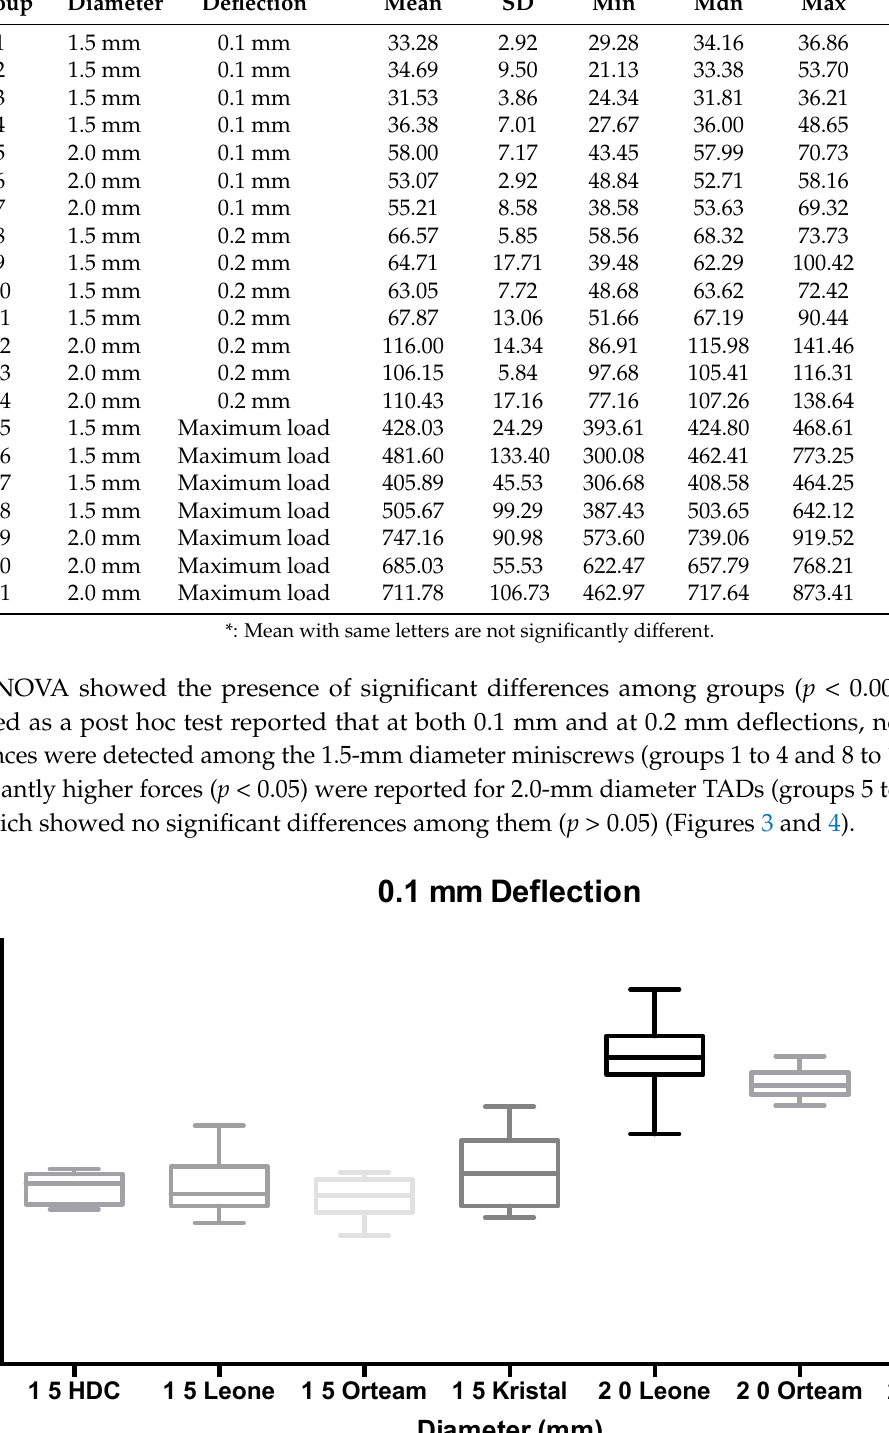
Table 2. Descriptive statistics of maximum force values (N) of the 21 groups tested (each group consisted of 10 specimens).